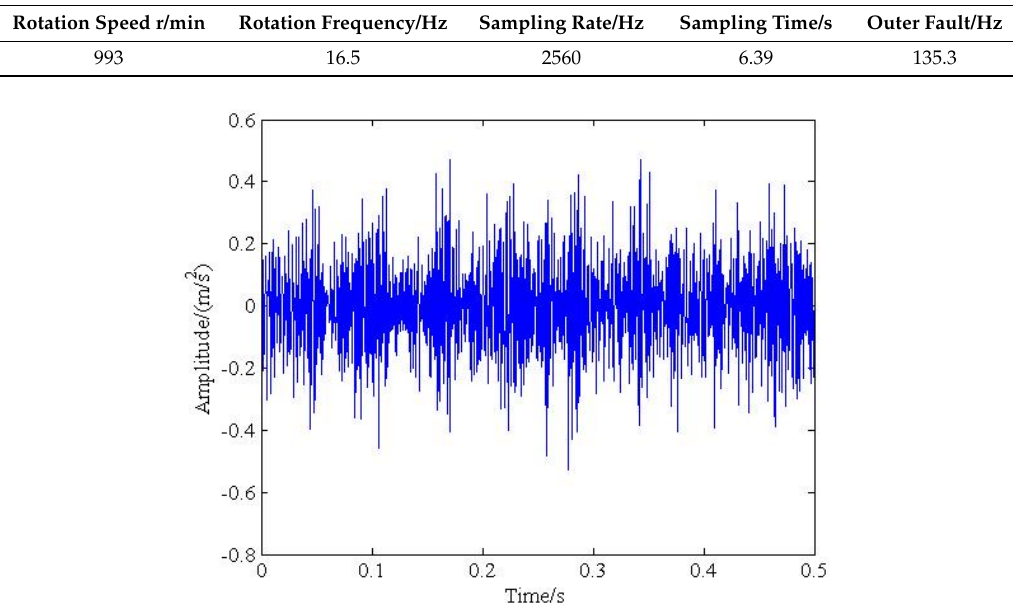
Table 3. The experiment parameter and failure frequency of fan.